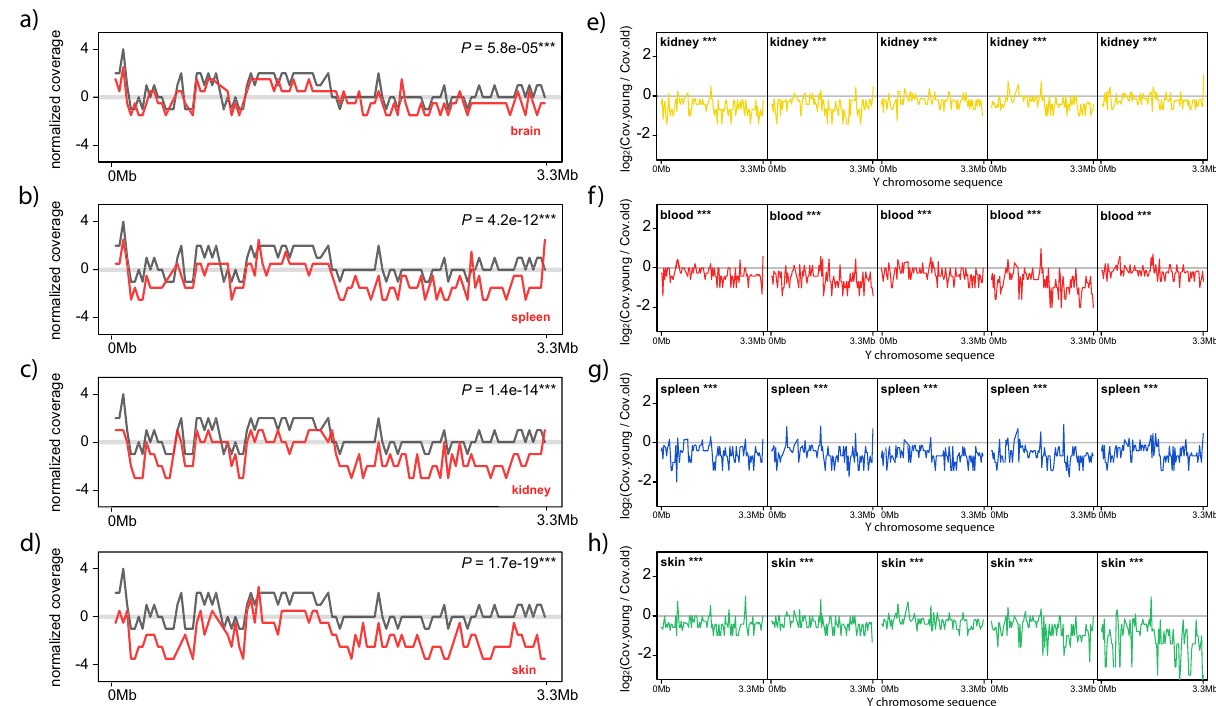
Fig. 3 Normalized sequencing coverage along the ChrY in samples from a young rat and old rats. a Normalized sequencing coverage from a young rat (grey line) and the normalized sequencing coverage from a brain sample with minor LOY (red line). b Same as in ( a ) but showing the normalized sequencing coverage from a spleen sample with medium LOY (red line). c Same as in ( a ) but showing the normalized sequencing coverage from a kidney sample with marked LOY (red line). d Same as in a) but showing the normalized sequencing coverage from a skin sample with marked LOY (red line). a – d Signi fi cant differences, Mann – Whitney U test between the coverage of the young and old samples. P values were Benjamin – Hochberg corrected. Exact P values are indicated. The grey line indicates the expected coverage in the absence of LOY. e – h Log2 ratios of the sequencing coverage in the young rat (Cov.young) divided by the sequencing coverage in old rats (Cov.old) using non-overlapping sliding windows of 100 kb over the fi rst 3.3 Mb of the Y chromosome sequence. The grey line indicates a log2 ratio of zero, which represents an identical coverage between the young and old rats. Log2 ratios above zero may indicate duplicated regions in the re-sequenced genomes that are not reported in the reference genomic sequence. Log2 ratios below zero may indicate loss of the Y chromosome in the re-sequenced genomes. Five samples from kidney are shown in yellow; fi ve samples from blood are shown in red; fi ve samples from spleen are shown in blue; fi ve samples from skin are shown in green. Signi fi cant differences, Mann – Whitney U test against a distribution with a fi xed median of 0 (similar sequencing coverage between the young and old samples). P values were Benjamin – Hochberg corrected: *** indicates P <